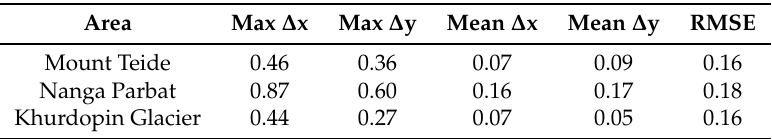
Table 2. Summary of the RPC refinement results. All values are in pixels. ∆ x and ∆ y are computed from Equations (5) and (6), respectively.